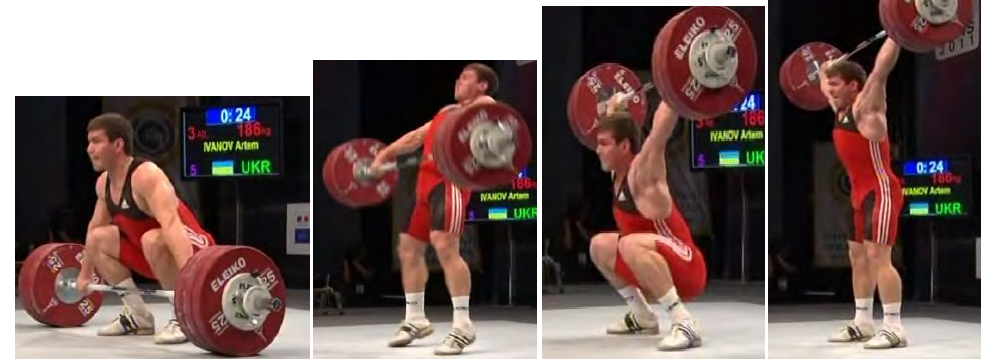
Fig.1. Technique of competition exercise “Classic snatch”